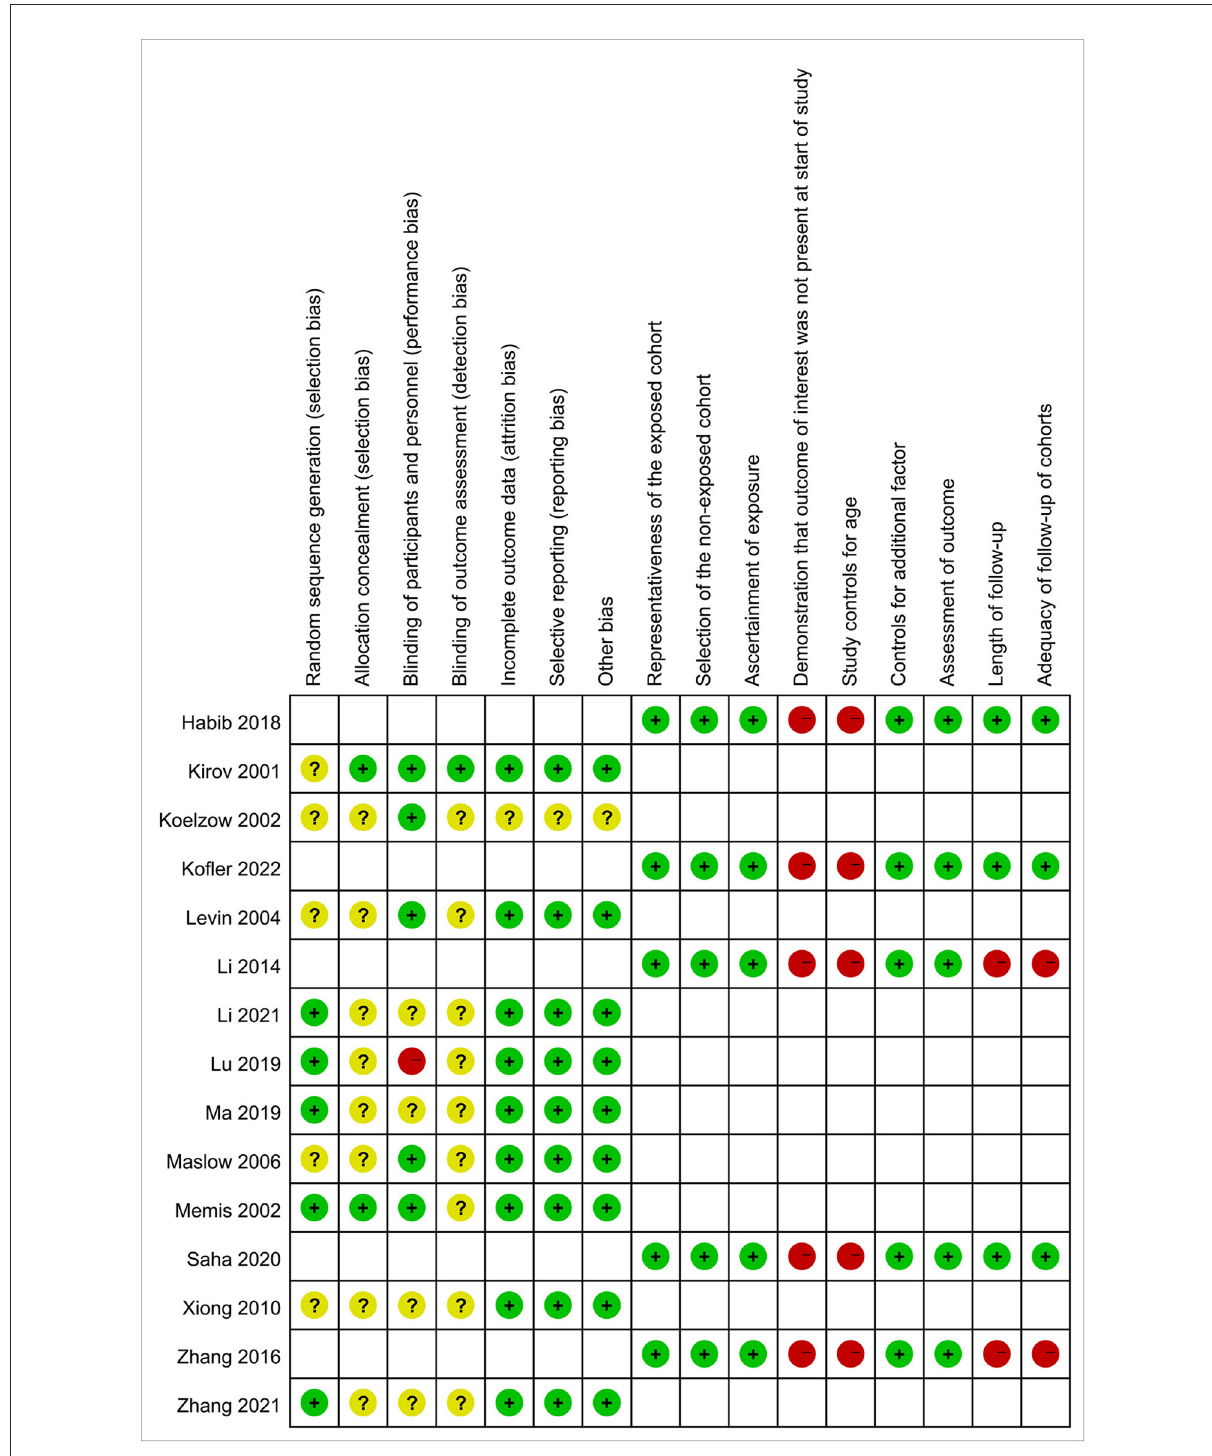
FIGURE2 Risk of bias summary assessments for included